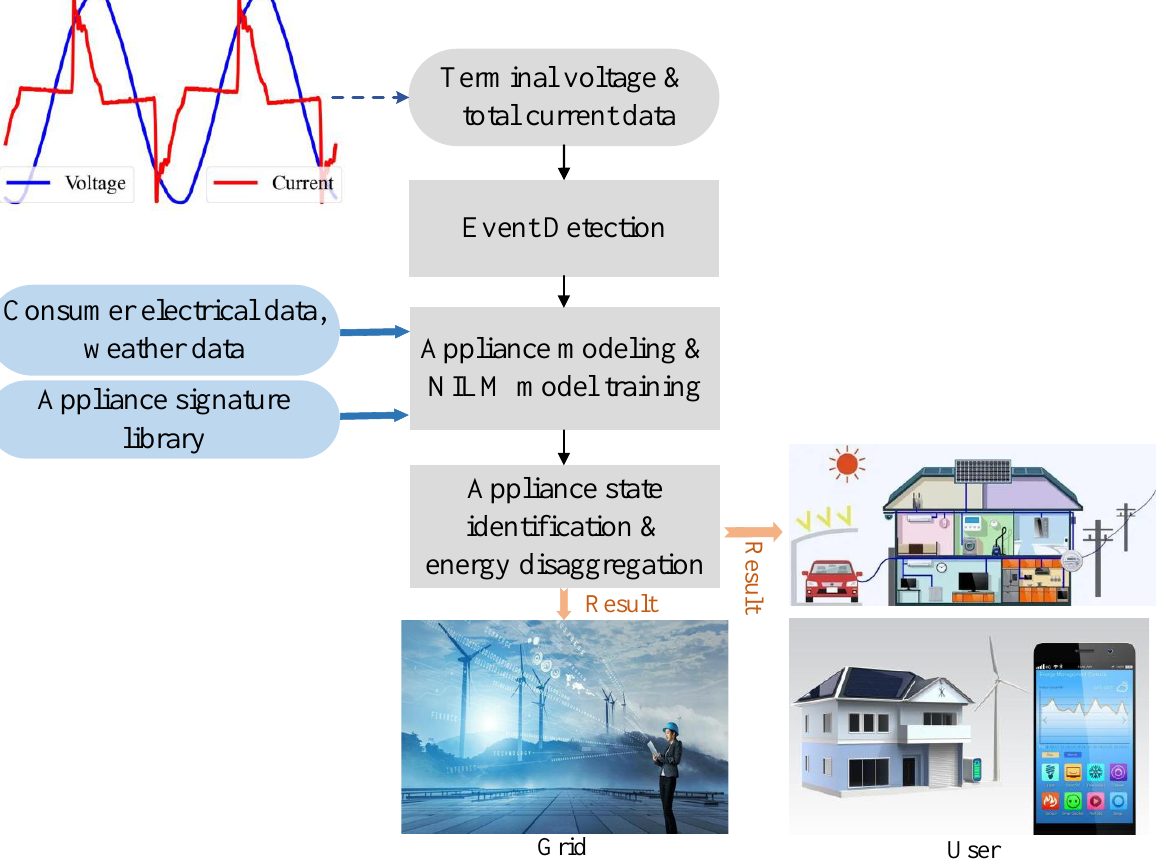
Figure 3. Typical event-based NILM